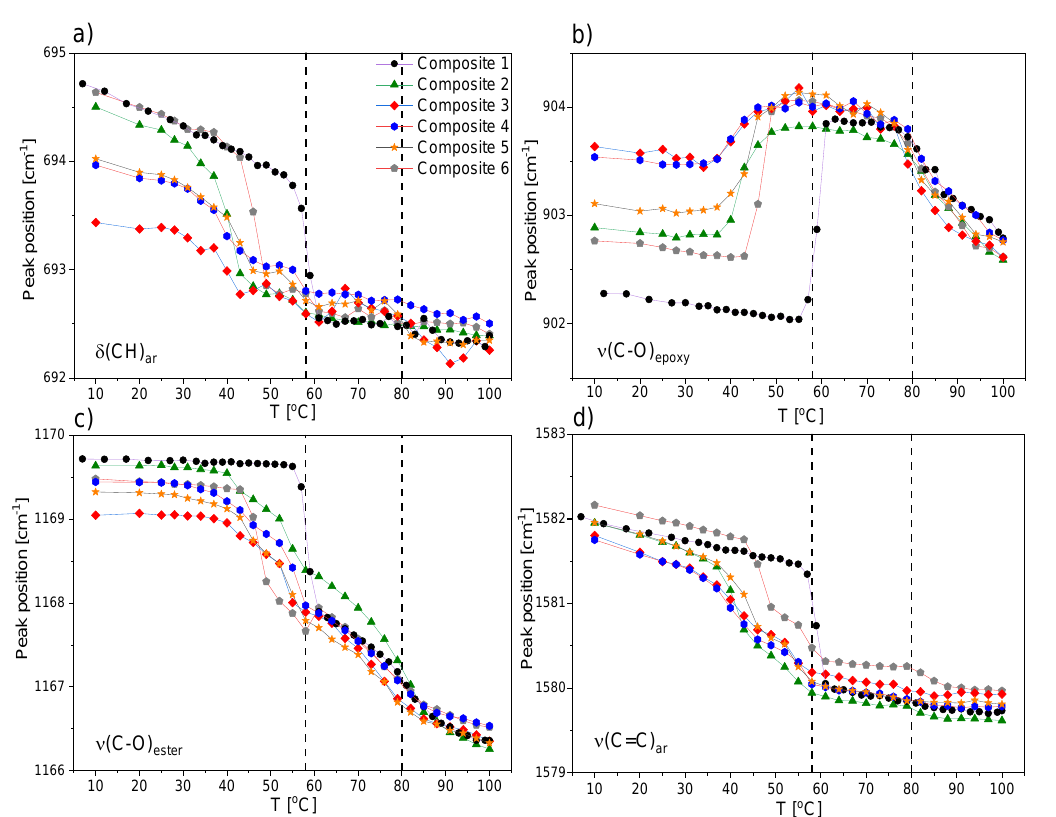
Figure 19. Temperature dependencies of peak maximum position for four selected IR bands connected to δ (CH) ar ( a ), ν (C-O) epoxy ( b ), ν (C-O) ester ( c ), and ν (C=C) ar ( d ) obtained for Composites 1–6 during cooling from the isotropic phase. The legend in graph ( a ) is the same for all graphs. The vertical dashed and dotted lines represent the SmA*–SmC* and SmC*–Cr 1 phase transition temperatures (during cooling) for pure EHPDB, respectively.